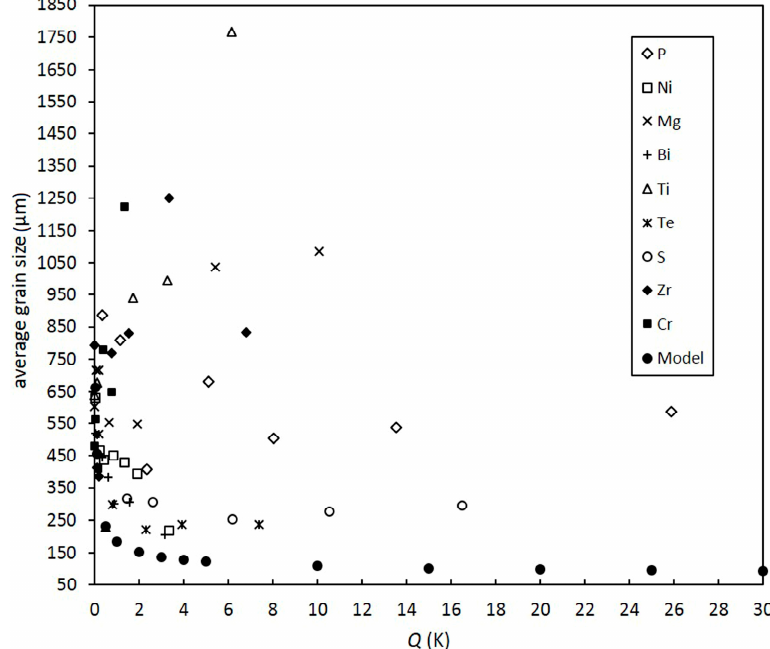
Figure 8. Grain size vs. Q for the alloying elements under investigation and the grain size obtained by the grain size model.